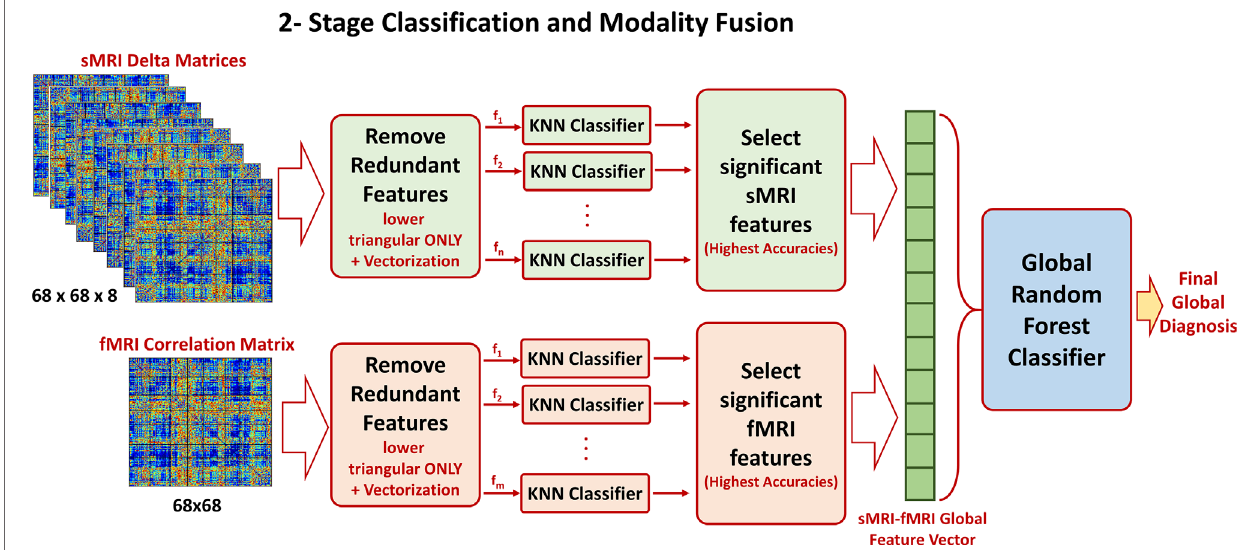
FIGURE 4 | The two-stage classification approach used. In the first stage, a local classification per feature in sMRI and fMRI feature matrices is used. The output accuracies of the first stage are used to create sorted feature vectors. An incremental approach is used to determine the optimal length of the sMRI and fMRI feature vectors. These two vectors are finally concatenated for the global classification.